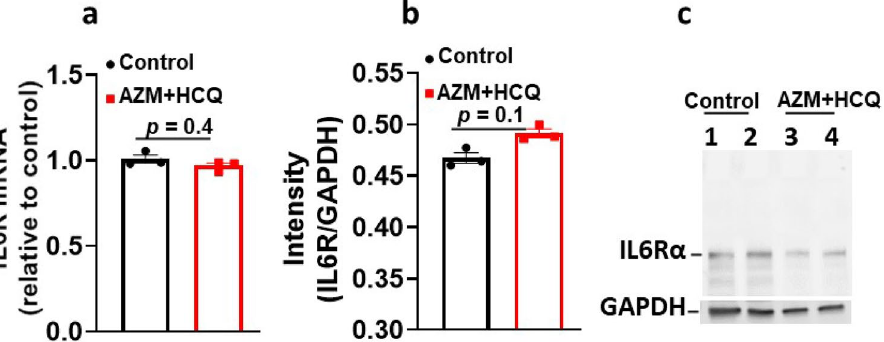
Figure 2. In vivo impact of azithromycin and hydroxychloroquine on the IL-6R transcript and proteins levels. ( a ) mRNA levels of IL6R in untreated guinea pig hearts (control) and in guinea pigs treated with AZM (1) and HCQ (2) for 30 min. ( b ) Densitometric analysis and ( c ) the corresponding western blot for IL6Rα proteins untreated guinea pig heart lysate (control) and guinea pigs treated with AZM (1) and HCQ (2) for 30 min. The blots were probed with a monoclonal antibody for IL6Rα (Anti IL6Rα—H7 Santa Cruz). The band at 80 kDa represents IL6Rα. GAPDH indicates internal control. Each experiment was performed in triplicates from 4 guinea pigs (2 controls, lanes 1 & 2 and 2 treated with AZM + HCQ, lanes 3 &